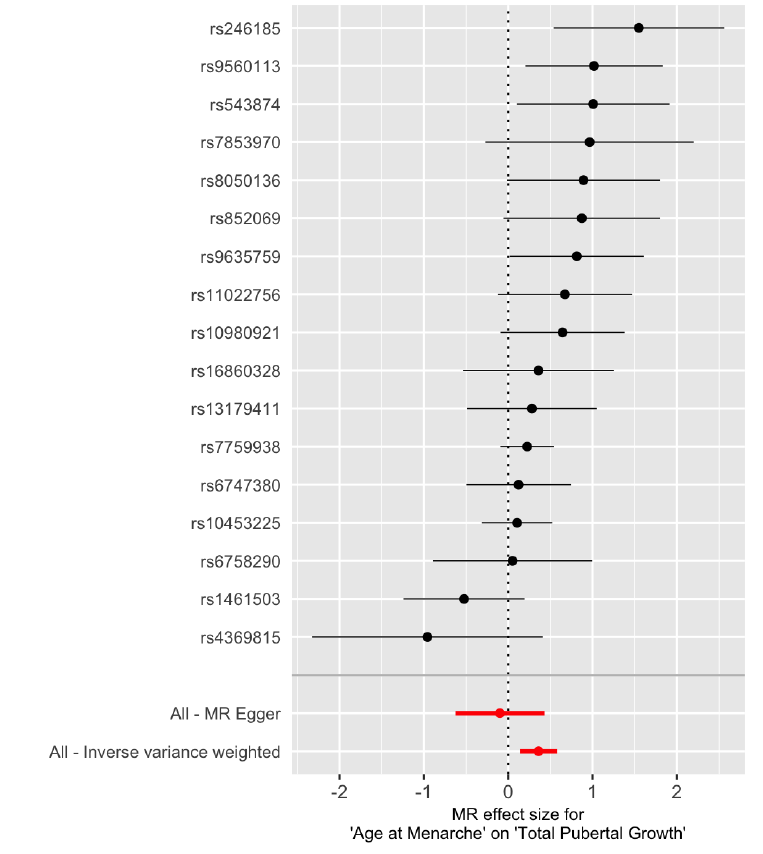
Figure 6. Forest plot of the Wald ratio Γ i / γ i at the 17 IV SNPs for total pubertal growth. The red points represent the MR estimates. SNP rs246185 and SNP rs4369815 are considered as